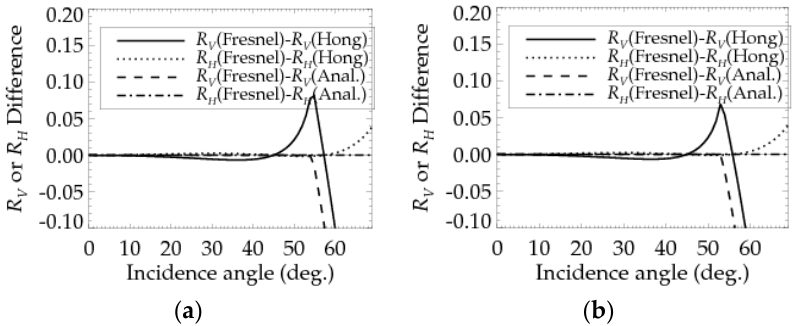
Figure 10. Errors in vertically polarized reflectivity ( R V ) and horizontally polarized reflectivity ( R H ) values between the Fresnel equation and the Hong approximation, and analytical approximation for ( a ) soil at 0.56 μ m and ( b ) water at 0.4 μ m.